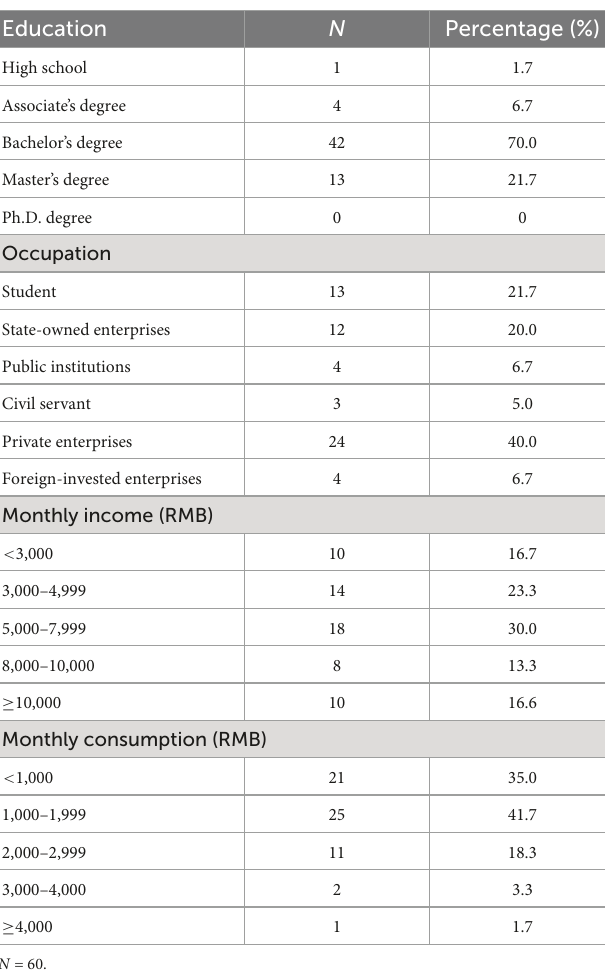
TABLE 4 Description of participants’ demographics in Study